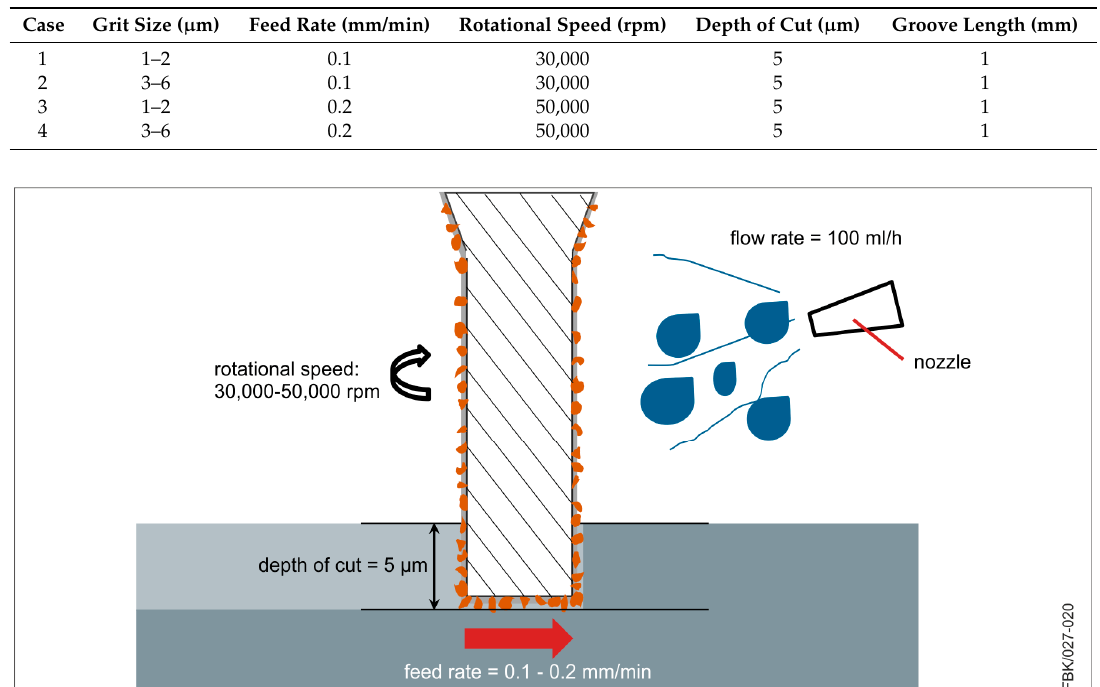
Figure 6. Micro grinding process kinematics.